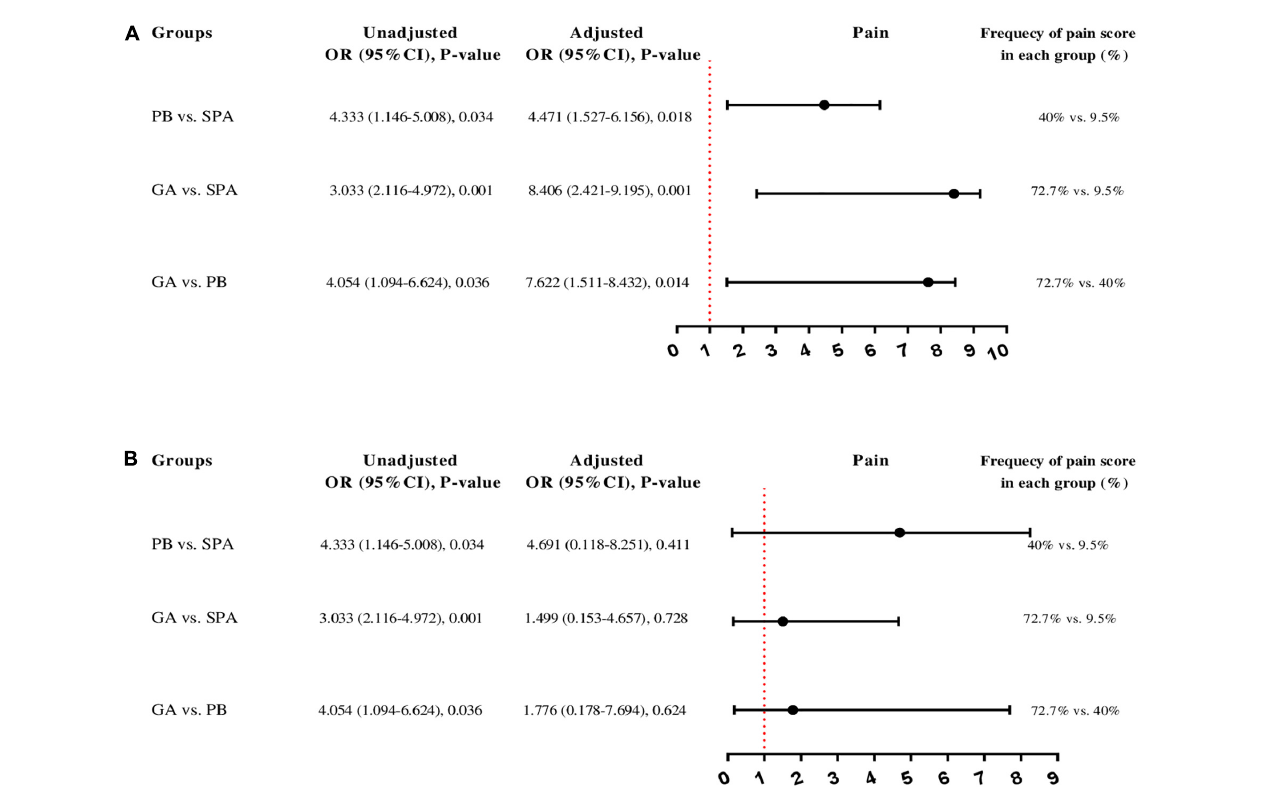
FIGURE5 Unadjusted and adjusted binary logistic regression analysis to predict pain score based on visual analog scale (VAS) between the three groups 0 of study; (A) the OR adjusting for age, weight, gravid, abortion, and cause of hysterectomy and forest blot figure shows adjusted OR, (B) the OR adjusting for surgery duration, anesthesia duration, return time of motor function and recovery duration and forest blot figure shows adjusted OR. In addition, the percent shows the frequency of pain score in each group. SPA, spinal anesthesia; PB, paracervical block; GA, general anesthesia; OR, odds ratio; CI, confidence